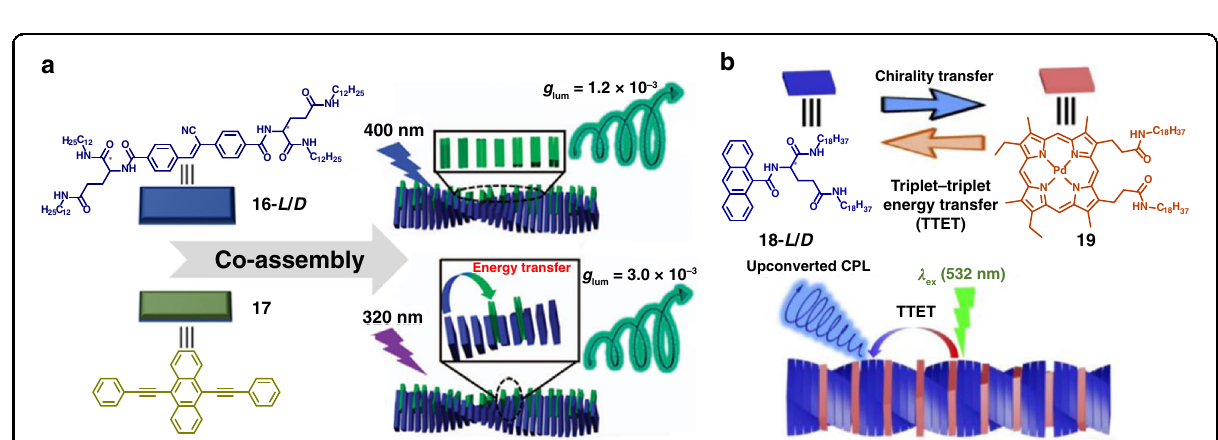
Fig. 3 Schematic diagram of energy transfer for amplifying CPL. a CPL from Föster resonance energy transfer in the co-assembly systems. b Uconverted CPL through triplet-triplet energy trsnsfer. Images reprinted with permission from: a ref. 57 from Springer Nature; b ref. 60 from Wiley